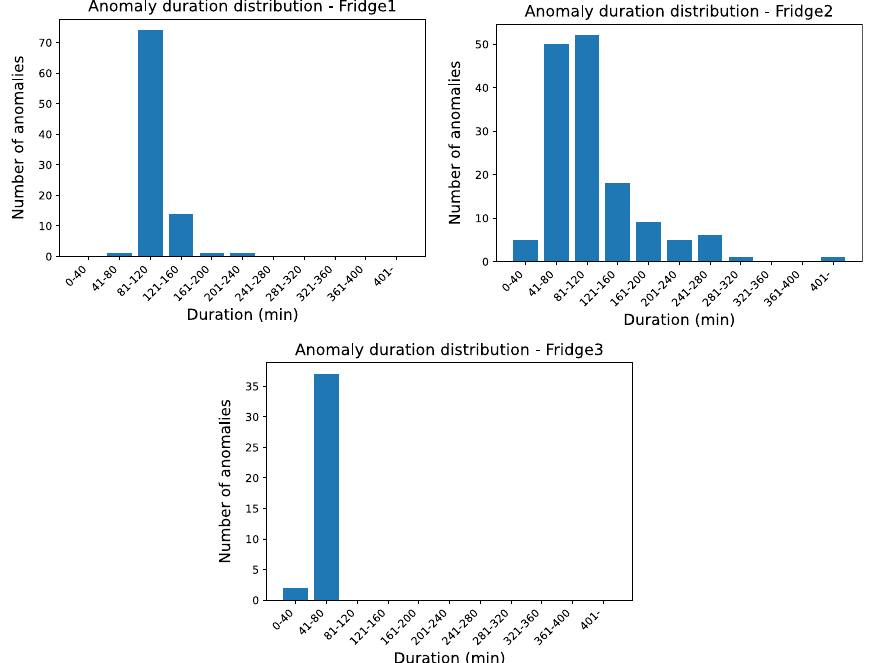
Fig. 5 The anomaly duration distribution on the fridge energy consumption data sets. The distributions of Fridge1 and Fridge2 are centered close the time series period, which suggests the presence of anomalies shorter than an ON-OFF cycle whereas the distribution of Fridge3 is centered around values higher than the mean ON-OFF cycle